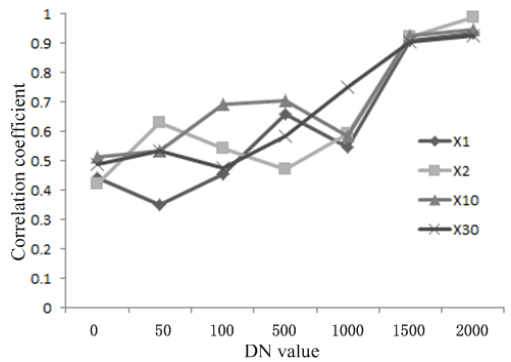
Figure 5. Correlation coefficient with the DN value